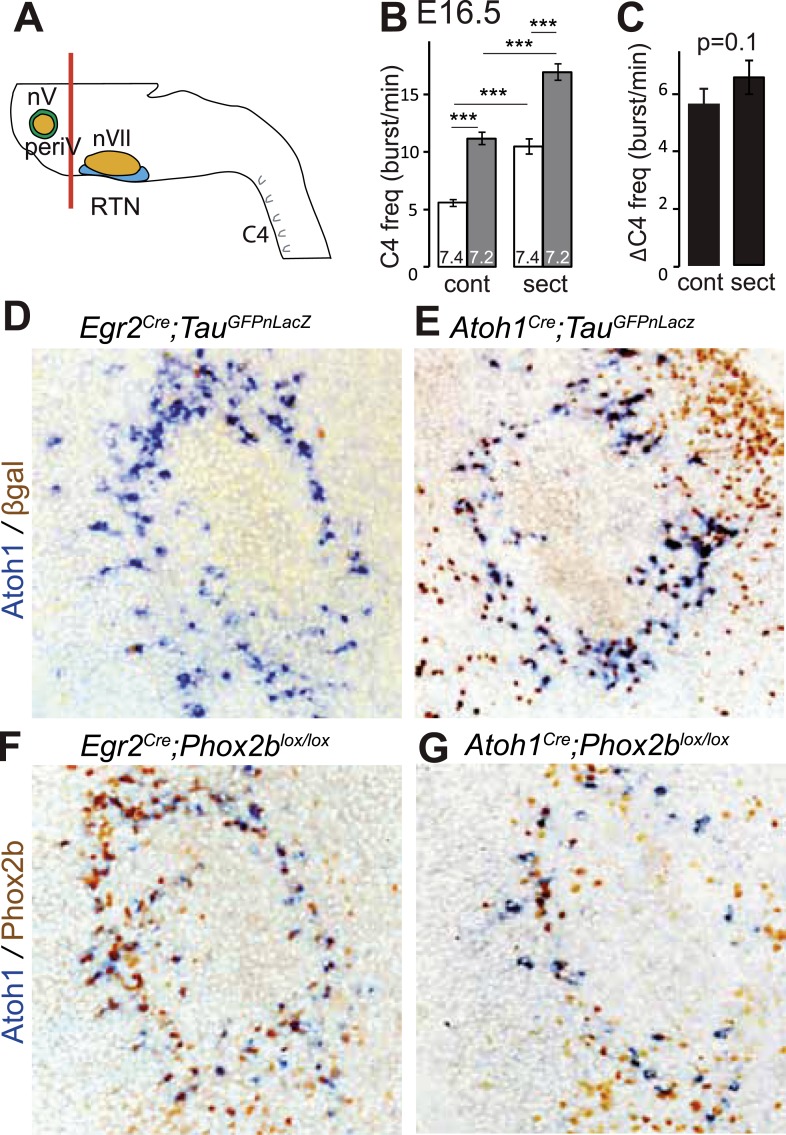
PeriV cells are not essential for the respiratory chemoreflex.(A) Schematic of a standard brainstem-spinal cord preparation showing the level of the section (red line) to eliminate the pons. (B) Comparison of C4 burst frequencies before and after sectioning in E16.5 wild-type preparations in normal and low pH conditions. The section (sect) increases baseline (white bar) frequency but preserves the response to acidification (grey bar), ***p < 0.001. (C) The changes of C4 frequency (ΔC4) induced by the pH challenge before (cont) and after sectioning (sect) are not significantly different from each other. (D and E) Combined ISH for Atoh1 and IHC for nuclearly localized βgalactosidase on coronal sections through the E15.5 pons, in the indicated genotypes. With Egr2 as Cre driver, expression of the TauGFPnLacZ reporter allele is not activated in periV cells (D), but it is expressed there when Cre is provided by Atoh1cre (E). (F and G) Combined ISH for Atoh1 and IHC for Phox2b on coronal sections through the E15.5 pons in the indicated genotypes. In the presence of Egr2Cre, Phox2b expression by the Atoh1+ cells is preserved in Phox2blox/lox embryos (F), but not when Cre is provided by Atoh1Cre (G). PeriV cells are not in the Egr2 lineage and can thus not be affected in Egr2Cre;Phox2blox/lox or Egr2Cre;P2b27Alacki mice, in which the respiratory chemoreflex is abrogated.